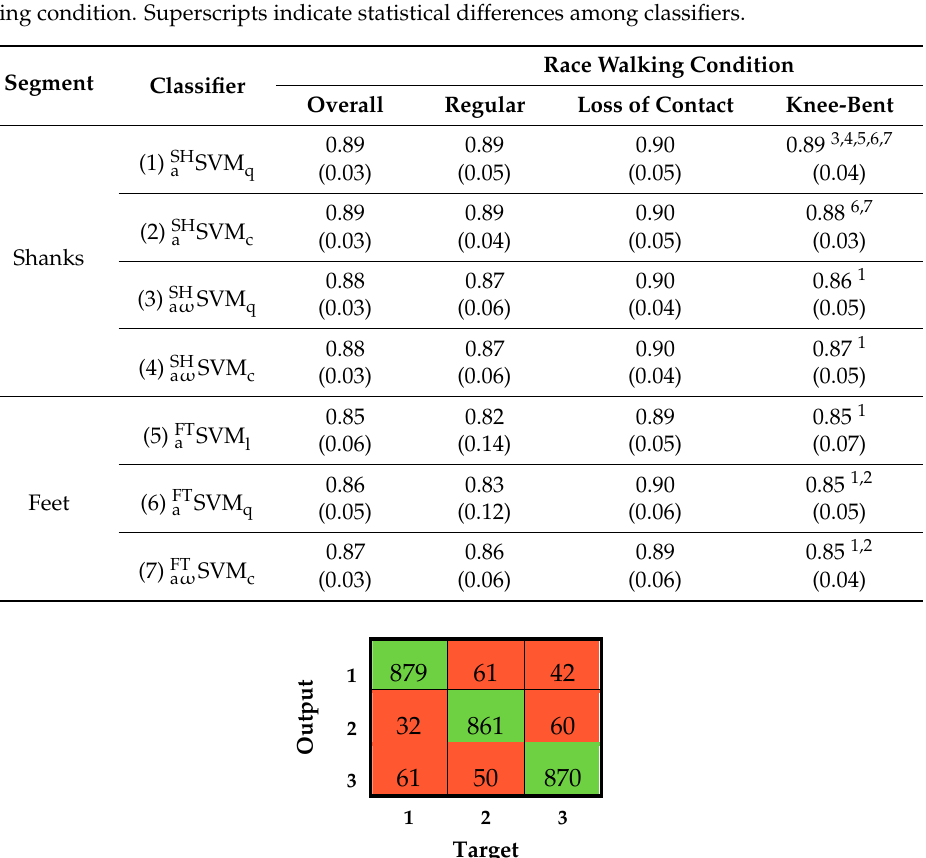
Table 7. Overall accuracy and goodness index related to the suitable classifiers that passed all previous selection criteria.